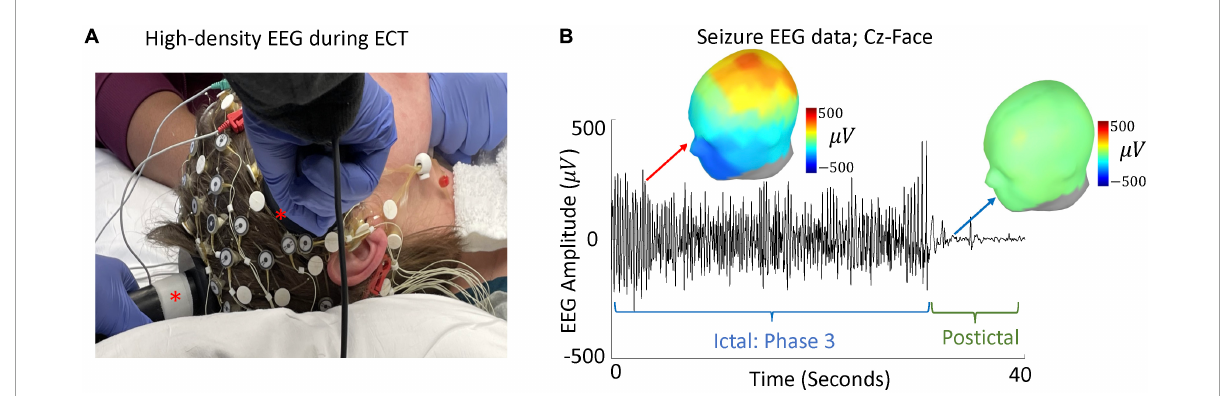
FIGURE2 High-density EEG during ECT and evaluation of CPCs. (A) A modified high-density 64-electrode EEG net with right unilateral ECT placement (ECT paddles marked with asterisks). (B) Data from a single seizure, during phase 3 and 10 s after seizure termination, is shown. EEG amplitude between Cz and suborbital facial electrodes (Cz-Face) is used to detect large amplitude CPCs. Green line shows seizure termination and onset of postictal generalized EEG suppression (PGES) (103, 104). Topographic maps represent spatial topology of EEG voltage during phase 3 (red arrow) and PGES (blue arrow).